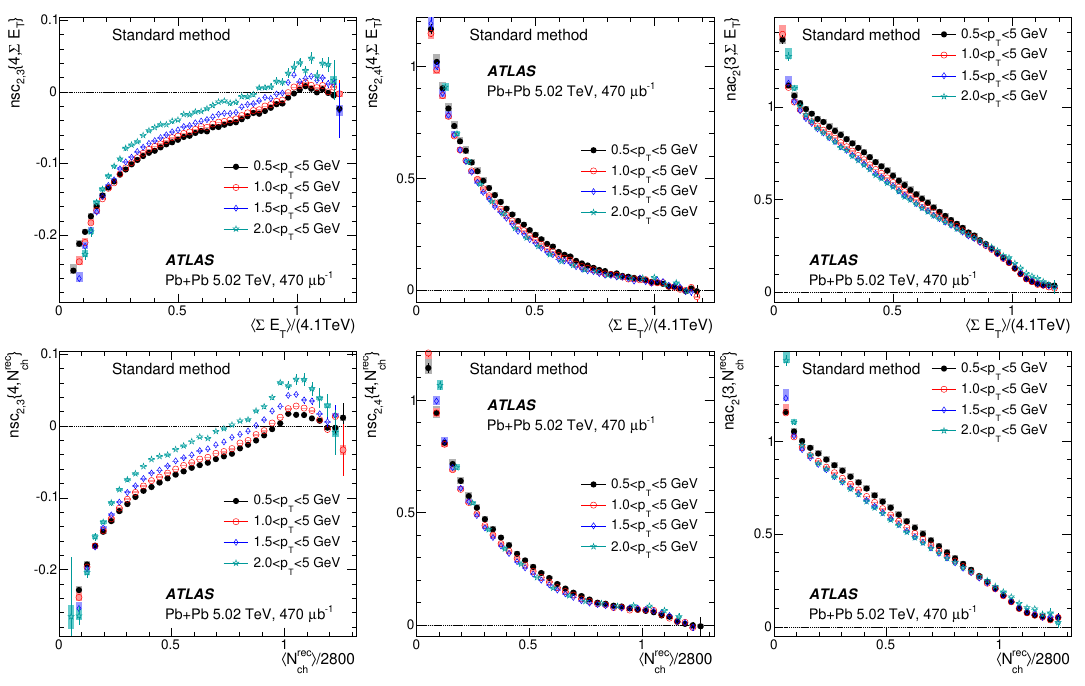
Figure 19 . The top row shows the h (cid:6) E T i dependence of normalized cumulants nsc 2 ; 3 f 4 ; (cid:6) E T g (left panel), nsc 2 ; 4 f 4 ; (cid:6) E T g (middle panel) and nac 2 f 3 ; (cid:6) E T g (right panel) for four p T ranges. The bottom row shows the h N rec i dependence of normalized cumulants nsc 2 ; 3 f 4 ; N rec g (left panel), ch ch nsc 2 ; 4 f 4 ; N rec g (middle panel) and nac 2 f 3 ; N rec g (right panel) for four p T ranges. The error bars and ch ch shaded boxes represent the statistical and systematic uncertainties, respectively. Zero is indicated by a dotted line.